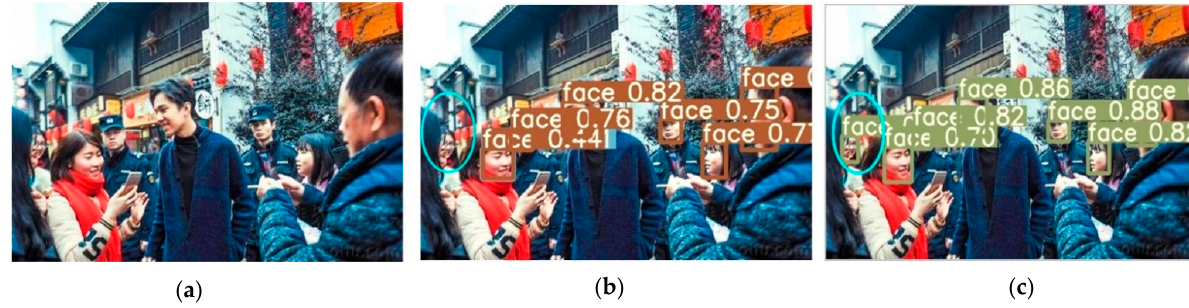
Figure 14. Detection of obscured targets. ( a ) Initial image sample; ( b ) YOLOv5 detect results; ( c ) YOLOv5-CBD detect results.